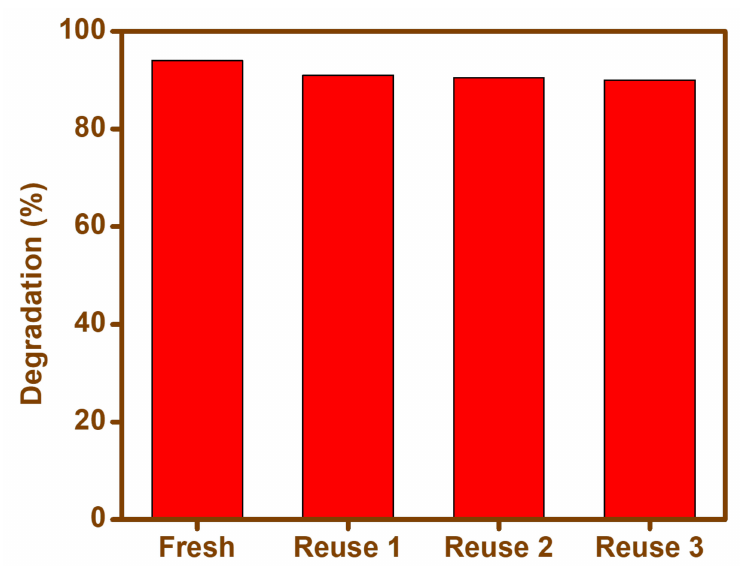
Figure 14. Reusability of BFO-M photocatalyst for the degradation of cefixime trihydrate.